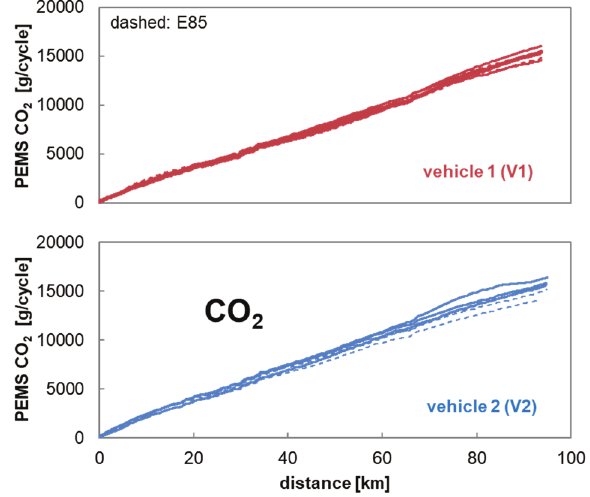
Fig. 5. NO x – Emissions during RDE with E0 and E85; Volvo V60 Flexfuel (V1); Audi A4 Flexfuel (V2)